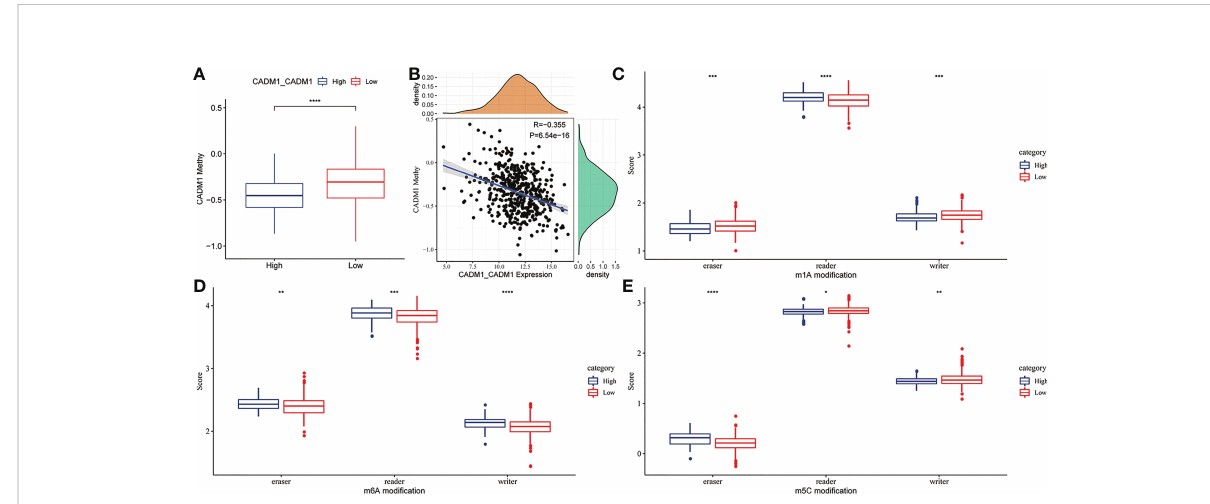
FIGURE 7 The relationship between CADM1-CADM1 and DNA, RNA methylation. (A) Comparison of CADM1 methylation in high CADM1-CADM1 group and low CADM1-CADM1 group. (B) Correlation analysis of CADM1-CADM1 and CADM1 methylation. (C – E) Comparison of the scores of erasers, readers, writers in m1a, m6a, m5c modi fi cation between high CADM1-CADM1 group and low CADM1-CADM1 group separately (****P < 0.0001, ***P < 0.001, **P < 0.01, *P < 0.05).